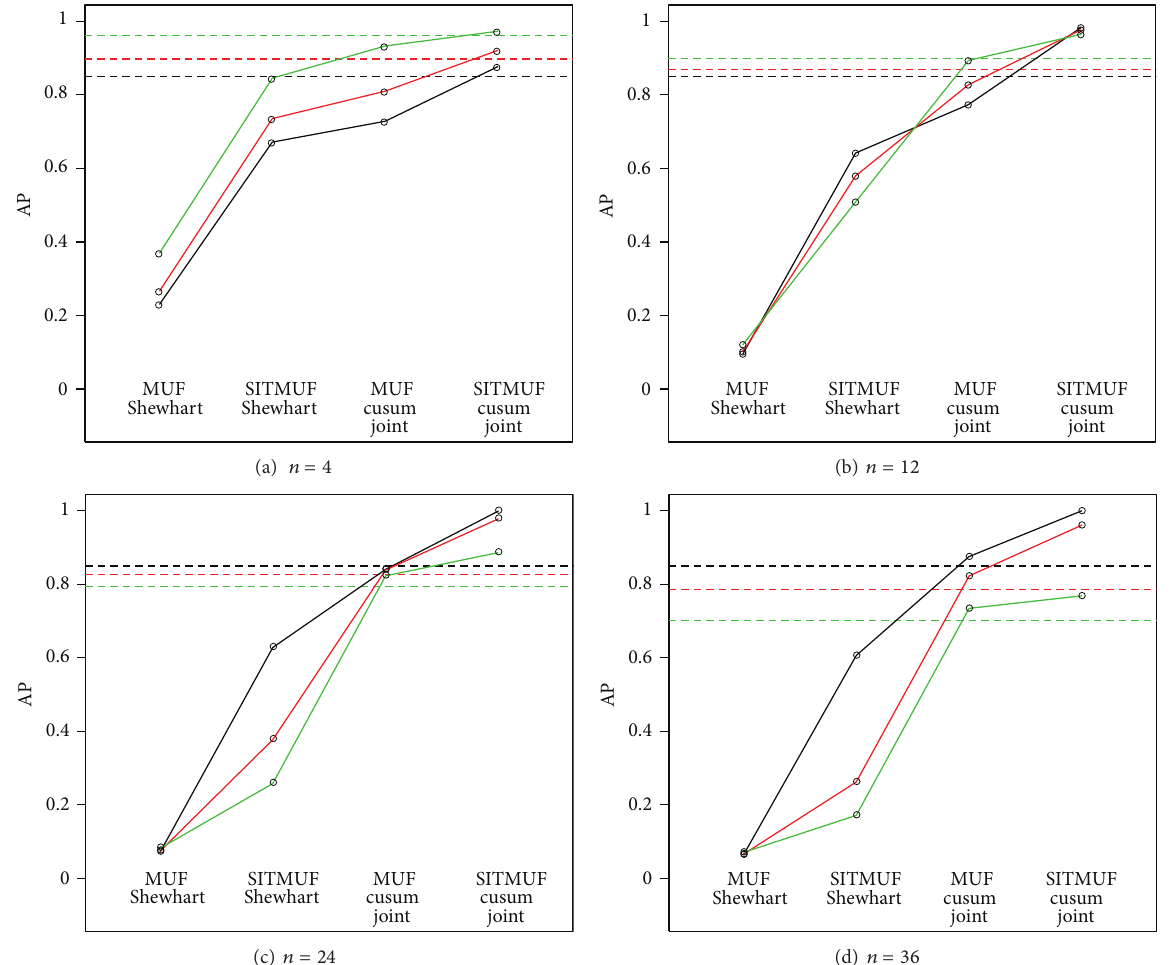
Figure 1: AP for protracted threat, 𝜎 𝑇 = 0.1 , 𝑀 = 4 . (Colors black, red, and green correspond to Σ 1 – Σ 3 . Dashed lines are for CUMUF.)